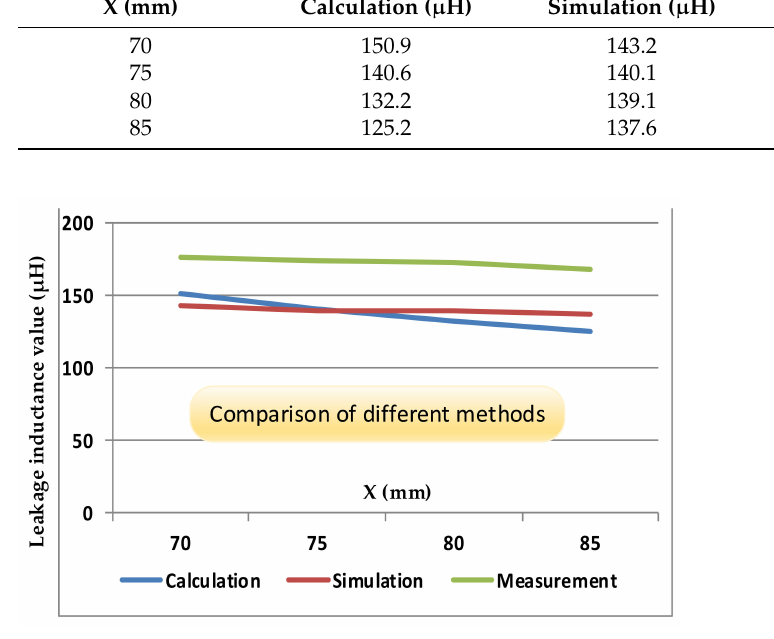
Figure 10. Comparison of leakage inductance value with different methods under parameter X